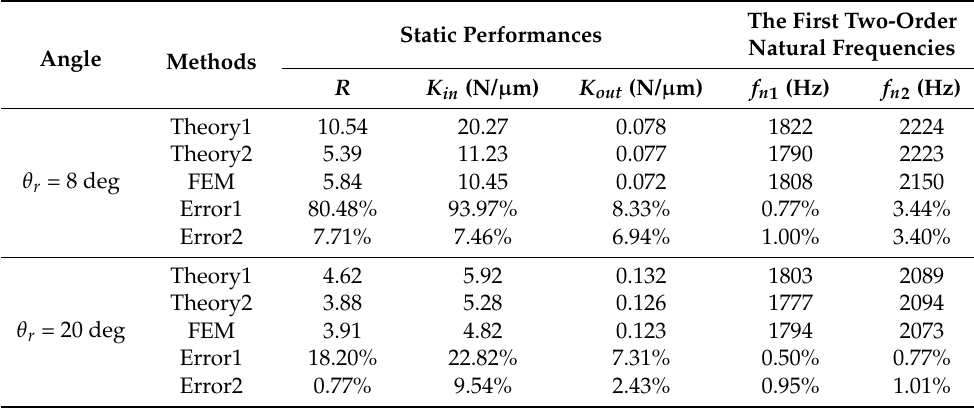
Table 4. Comparison on the static and dynamic performances of the displacement amplification mechanism provided by the presented model and finite element method (FEM). The First Two-Order Static Performances Natural Angle Methods